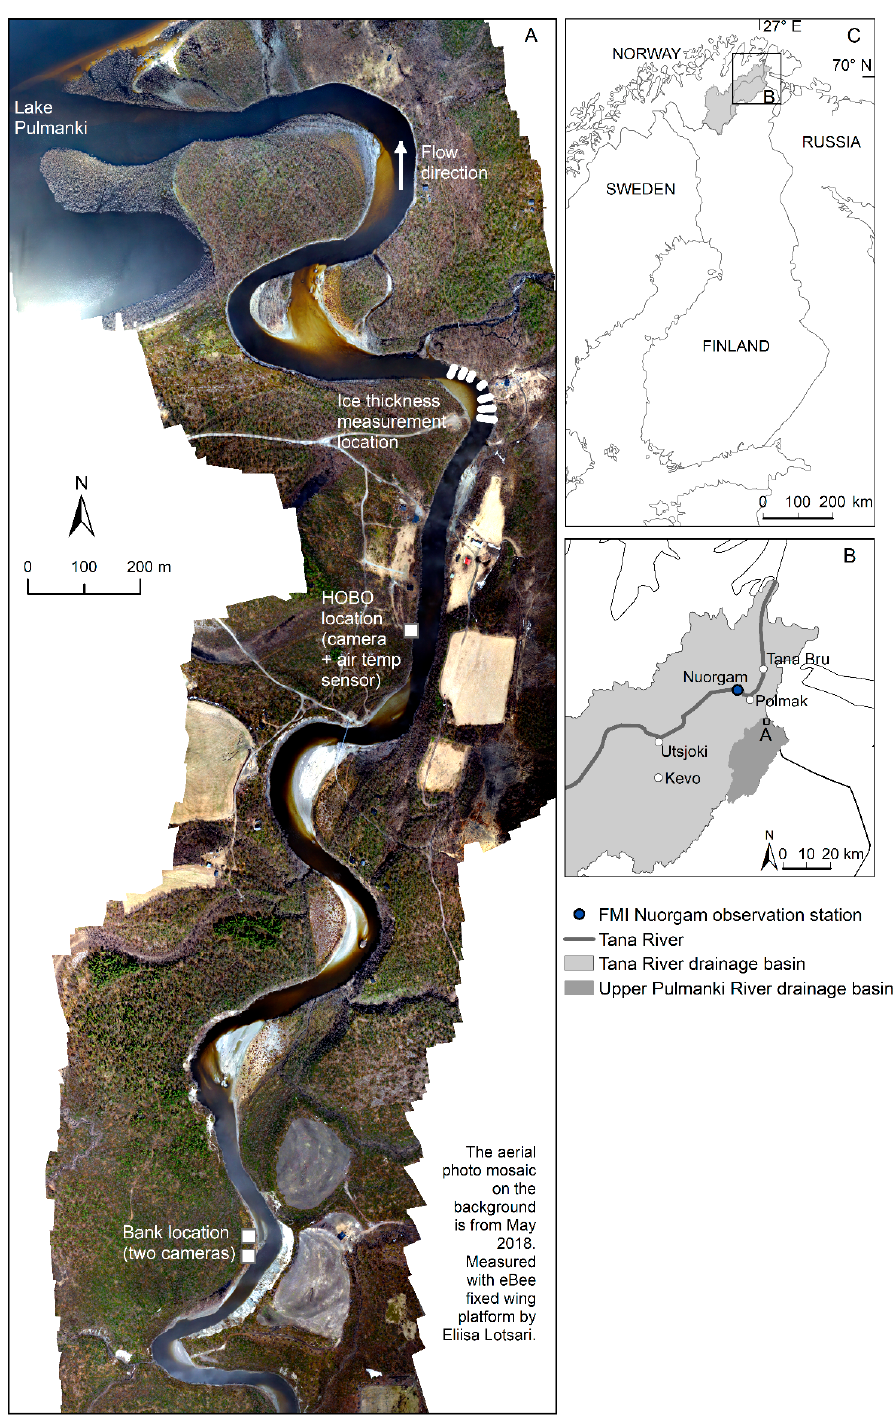
Figure 1. ( A ) The Pulmanki River study site and the measurement locations. The cameras have been filming at the bank location since autumn 2015, and at the HOBO (i.e., Honest Observer By Onset) sensor location since February 2019. ( B ) The Upper Pulmanki River locates within the Tana River watershed. The detailed study location is marked with “A”. The Finnish Meteorological Institute’s (FMI) weather station is at Nuorgam, approximately 20 km north from the Pulmanki study site. ( C ) The Pulmanki River locates in Northern Finland and is a tributary to the Tana River that forms a border between Finland and Norway.